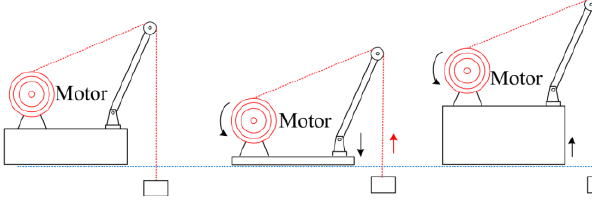
Figure 1. Draw-works retractable type [12].